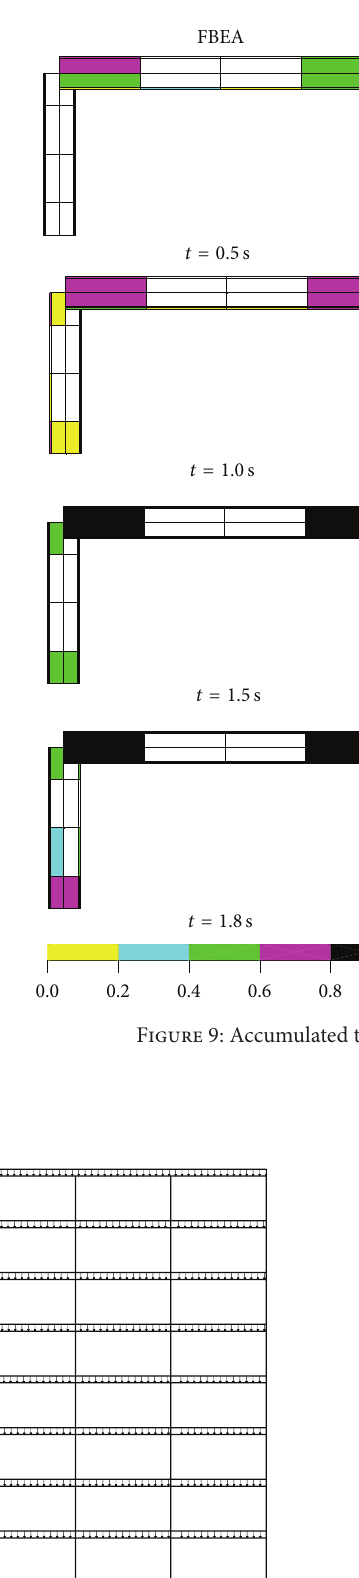
Figure 10: Finite element mesh of 8-story RC frame with soft-story.